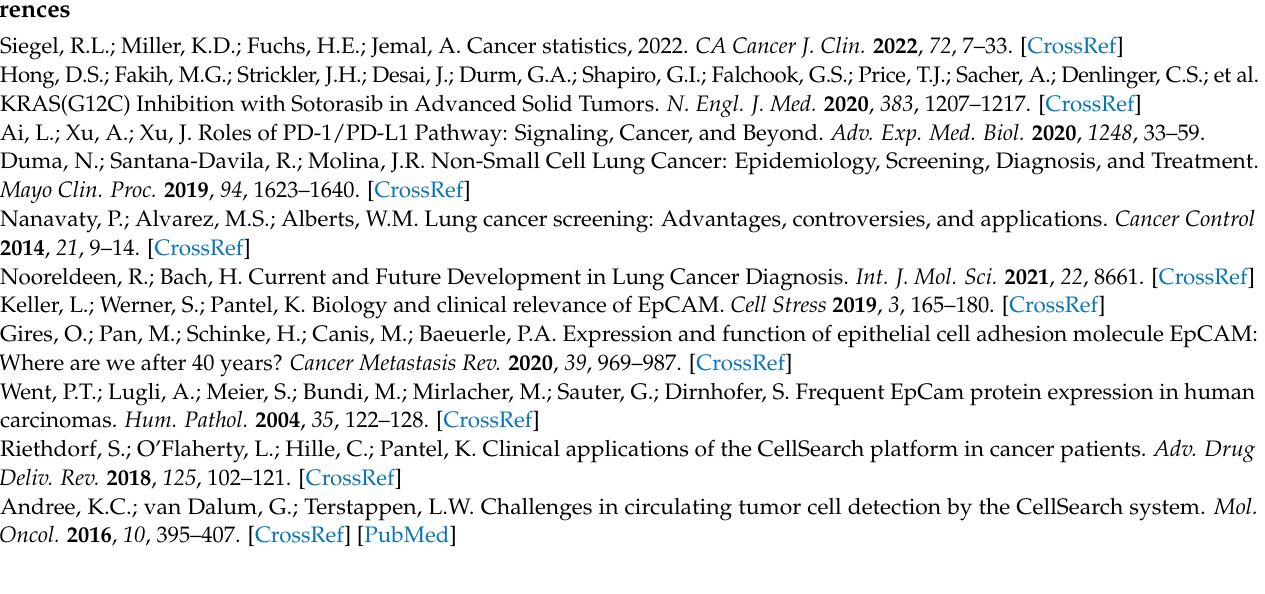
Figure 1I; Figure S2: Original western blot used in Figure 4D; Figure S3: EpCAM expression in poorly metastatic lung cancer cell lines; Figure S4: EMT signaling may contribute to EpCAM repression; Figure S5: The expression and copy number of EpCAM in human primary cancers; Figure S6: